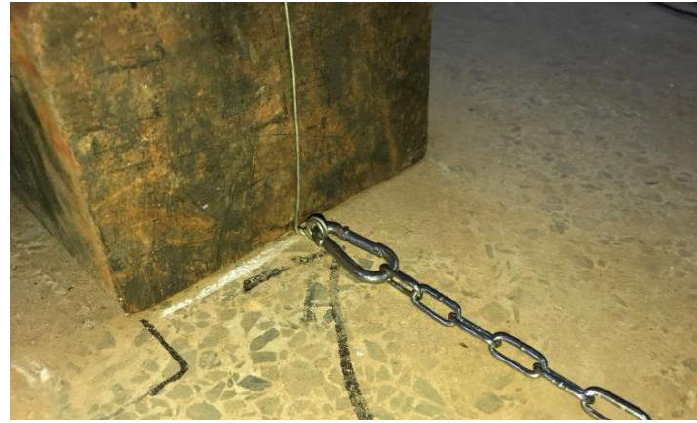
Figure 20. Anchorage point at the bottom of the sea. Table 2. Mooring line parameters of material properties. Table 4. Coordinates of fairlead and anchorage points of the